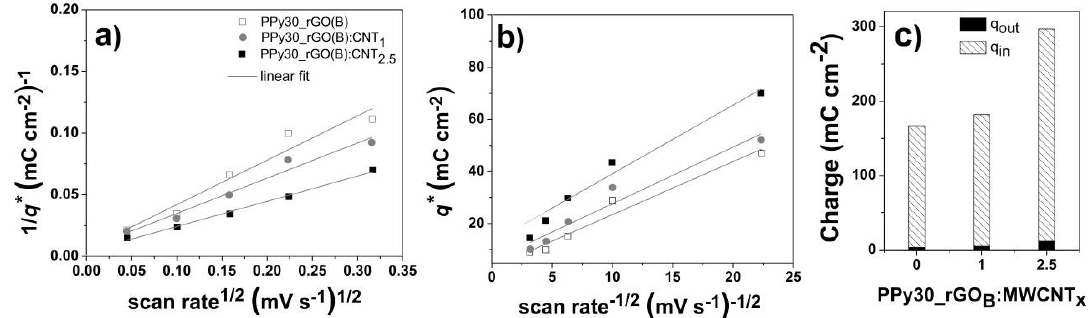
Figure 6. Trasatti plots ( a and b ) and the contribution to the total stored charge from the outer ( q out ) and inner ( q in ) charge components ( c ).